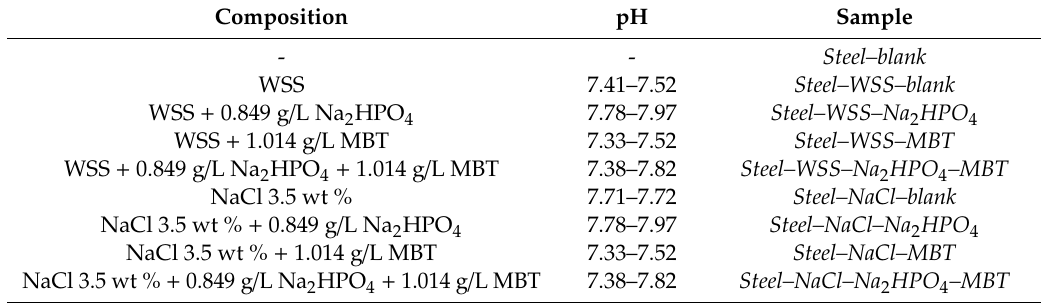
Table 2. Composition of the solutions for testing the e ff ectiveness of the inhibitors onto mild